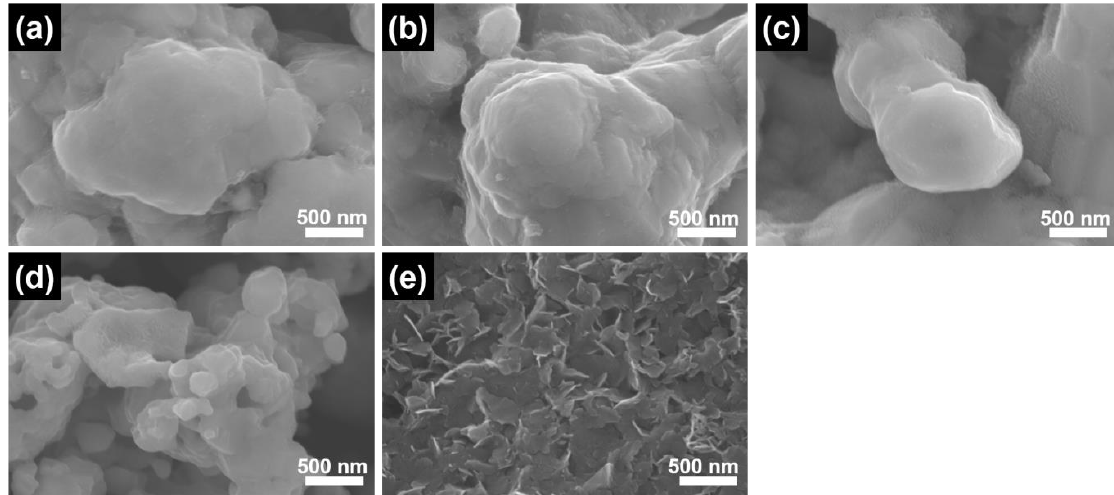
Figure 4. SEM images of Ni nanoparticles synthesized at 140 °C with different concentration ratio of Ni:AB as ( a ), 1:0.1. ( b ), 1:0.2 ( c ) 1:1, ( d ) 1:2, and ( e ) 1:4 respectively.